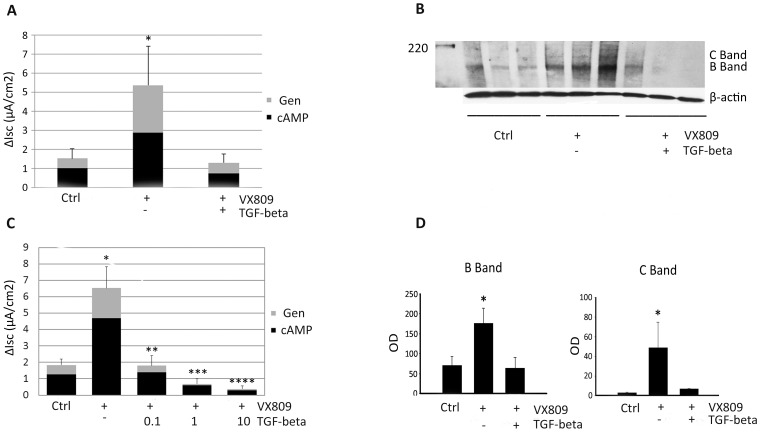
TGF-beta downregulation of VX-809-corrected F508del CFTR in HAECs.F508del CFTR homozygous HAECs were grown at air-liquid interface culture for 6 weeks and treated with TGF-beta (10 ng/ml) and/or VX-809 (3 µM) for 48 h prior to Isc measurement. (A) Stimulated Isc under control (left), VX-809 alone (middle), or VX-809 + TGF-beta (right) treatment conditions. *P<0.035, VX-809 compared with either control or VX-809 + TGF-beta. (B) Lysates of F508del HAECs from each filter were prepared and subjected to PAGE and immunoblot as described in Methods for detection of B Band and C Band under control, VX-809 alone, or VX-809 + TGF-beta treatment conditions. (C) All tested doses of TGF-beta downregulated VX-809-corrected F508del CFTR. *P<0.00017, VX-809 compared with untreated control; **P<0.0001, 0.1 ng TGF-beta + VX-809 compared with VX-809 alone. ***P<0.0001, 1 ng TGF-beta + VX-809 compared with VX-809 alone. ****P<0.0001, 10 ng TGF-beta + VX-809 compared with VX-809 alone. (D) Summary densitometry data for detection of F508del CFTR B Band (left) and C Band (right) with and without TGF-beta (10 ng/ml, similar to 5B). *P≤0.047, B Band VX-809 compared with either control or VX-809 + TGF-beta. *P≤0.05, C Band VX-809 compared with either control or VX-809 + TGF-beta.